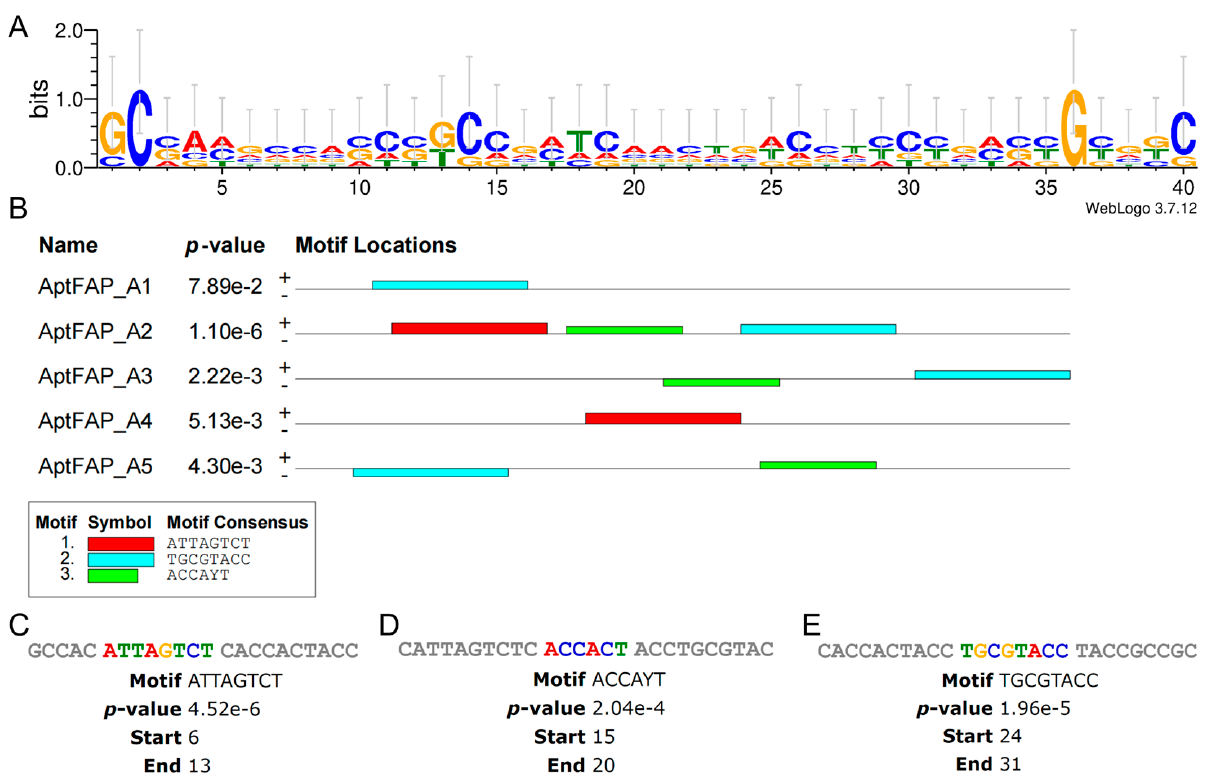
Figure 2. Secondary and tertiary structure prediction of candidate aptamers. ( A – E ) The secondary and tertiary structures of AptFAP-A1~AptFAP-A5 were predicted by the NUPACK software and the 3dRNA/DNA tertiary structure prediction method, respectively.